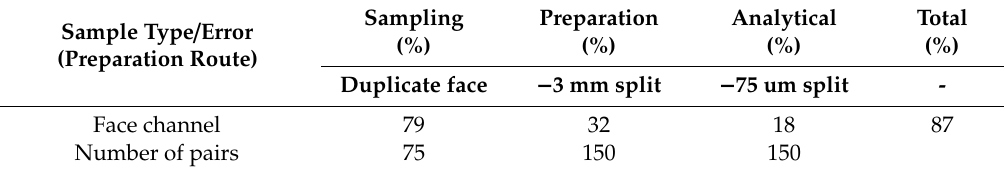
Table 17. Face channel sample duplicate pair analysis.